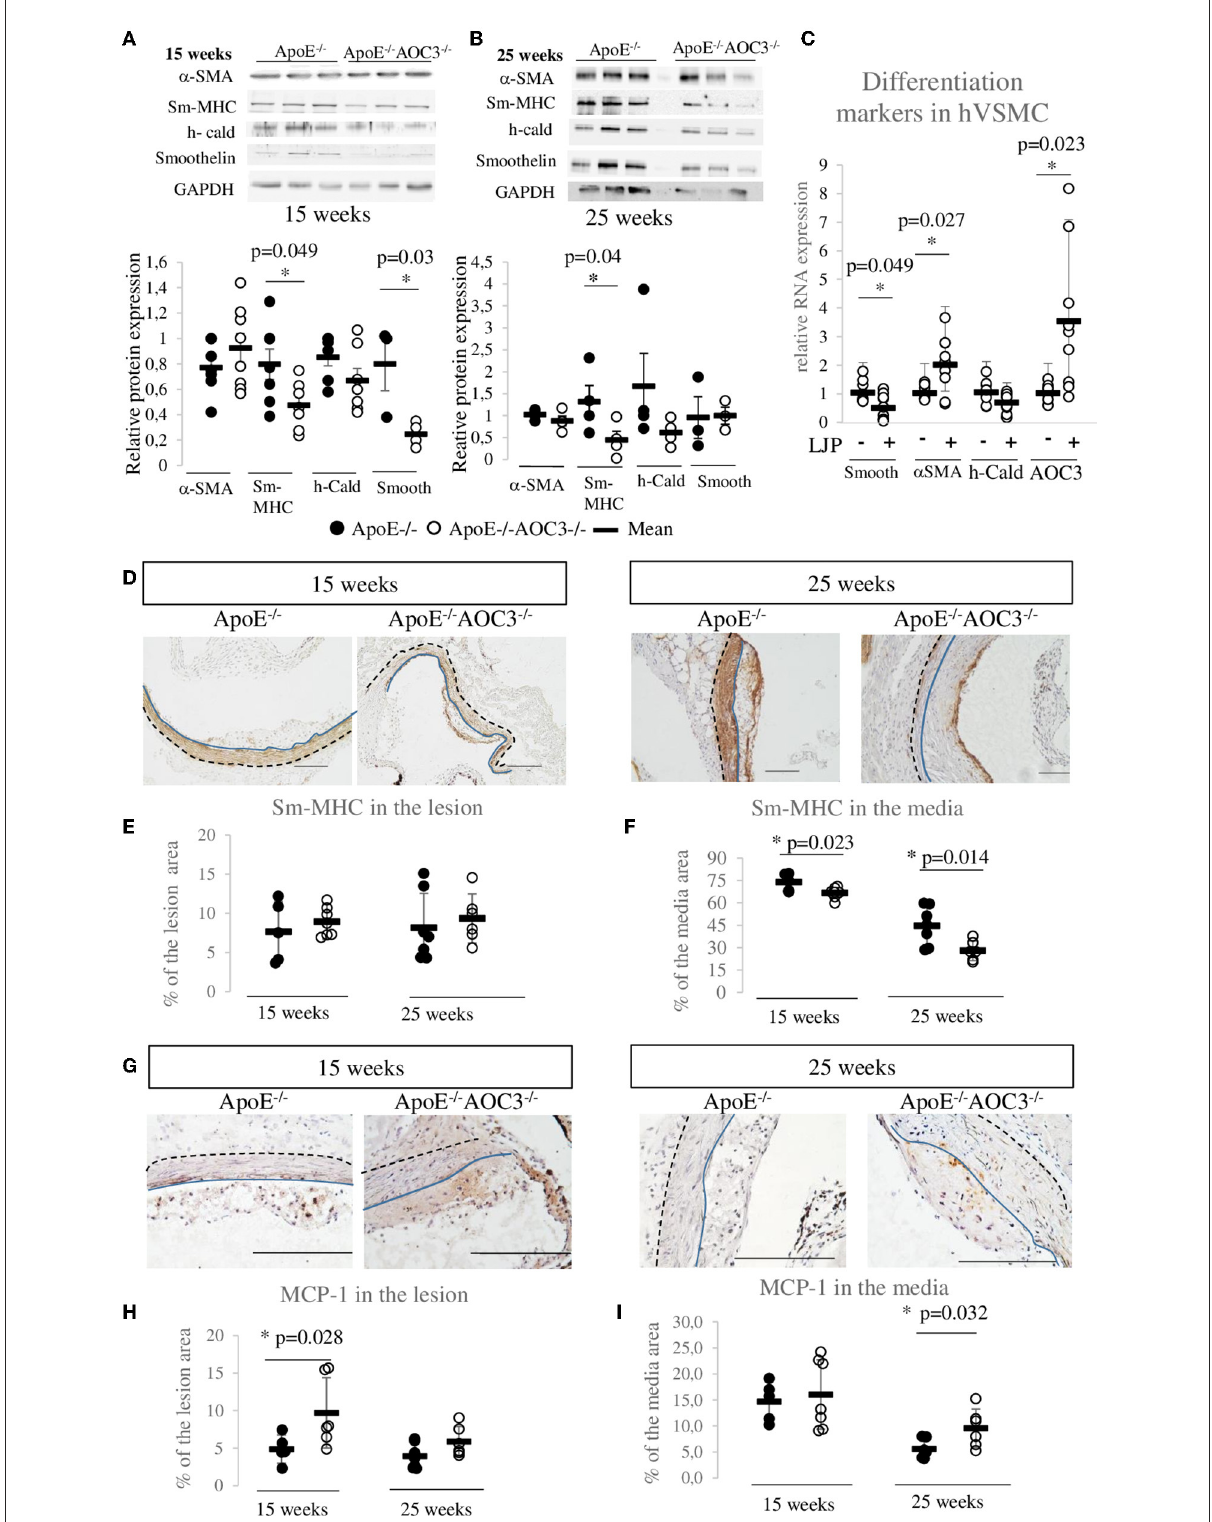
FIGURE3 VSMC dedifferentiation and MCP1 increase induced by AOC3 knockout. VSMC differentiation markers (Sm-MHC), α -actin ( α -SMA), h-caldesmon (h-Cald), and smoothelin (smooth) were quantified in abdominal aortas from ApoE − / − ( (cid:8) ) and ApoE − / − AOC3 − / − ( ◦ ) female mice by